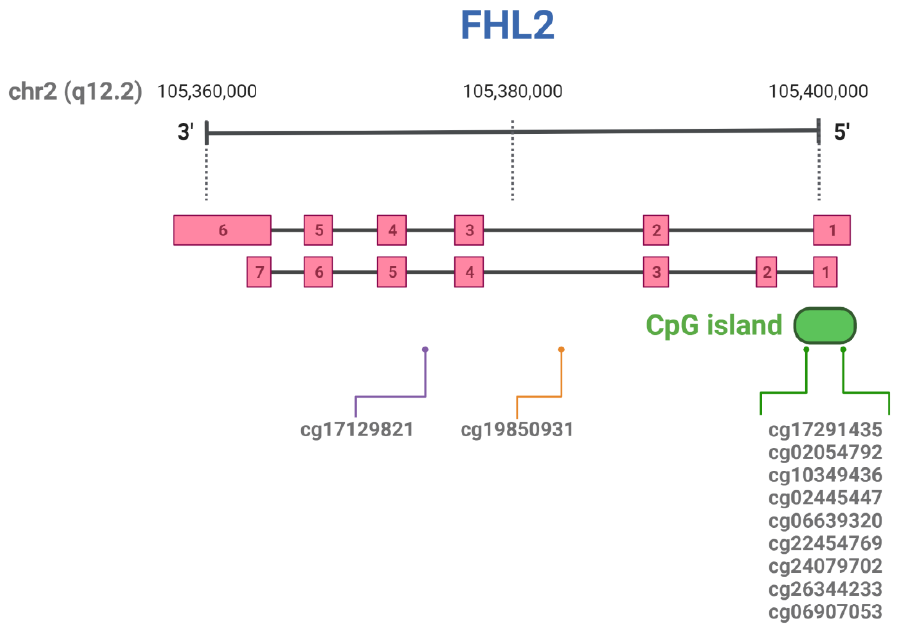
Figure 4. Schematic representation of FHL2 transcript variants (exons are sequentially numbered) and relevant CpG sites, according to Genome Browser (GRCh38/hg38 and GRCh37/hg19). Created with BioRender.com. Table 2. Table of CpG sites in the FHL2 gene found in the literature. Position in chromosome based on genome version a GRCh37/hg19 or b GRCh38/hg38.